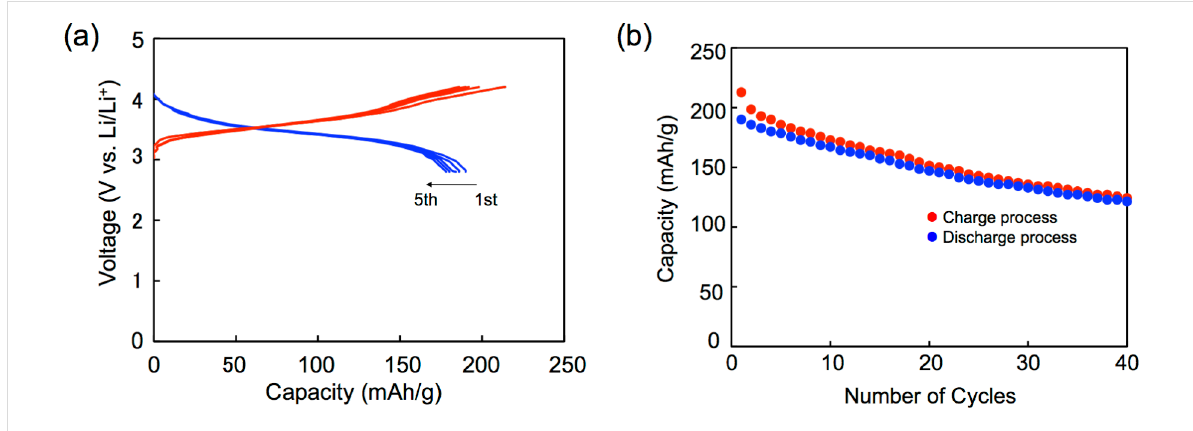
Figure 8: (a) Galvanostatic charge–discharge curves, and (b) cycle-life performances for a 8c /Li cell.